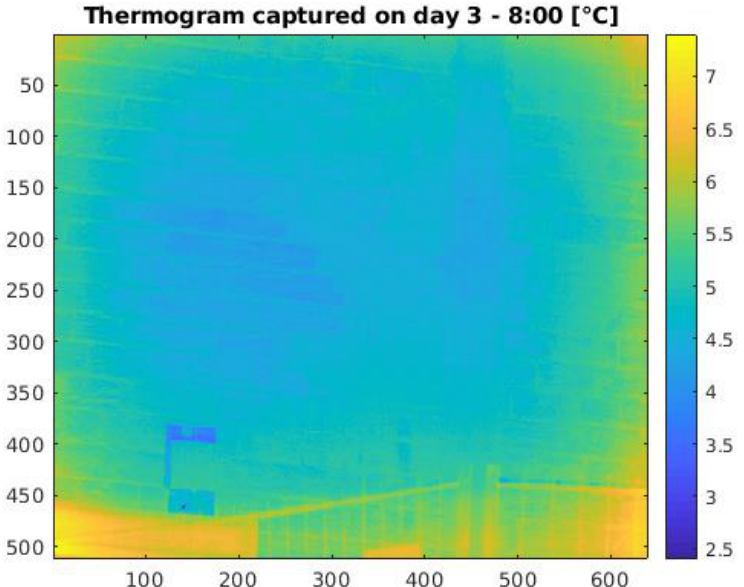
Figure 7. Typical thermogram showing the retaining wall. In the lower left are the two reference plates stacked on top of each other. Note the vignetting effect on the cameras lens has not been fully corrected. However, for the proposed algorithm, this correction is not necessary.